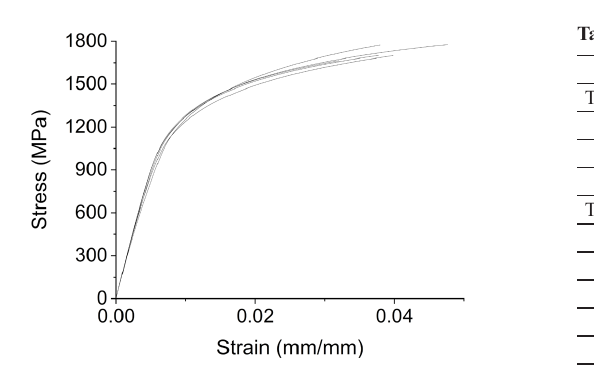
Figure 7. Engineering stress–strain curves of the tested specimens.